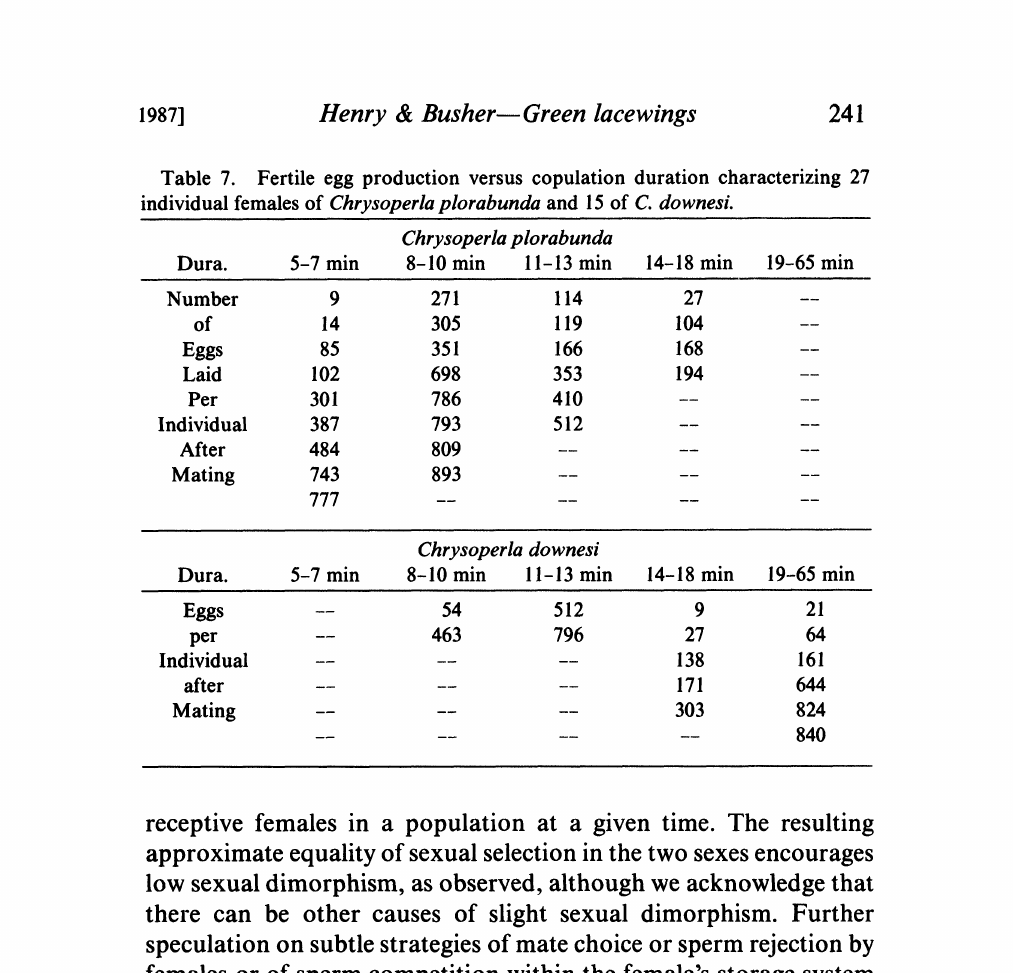
Table 7. Fertile egg production versus copulation duration characterizing 27 individual females of Chrysoperla plorabunda and 15 of C.